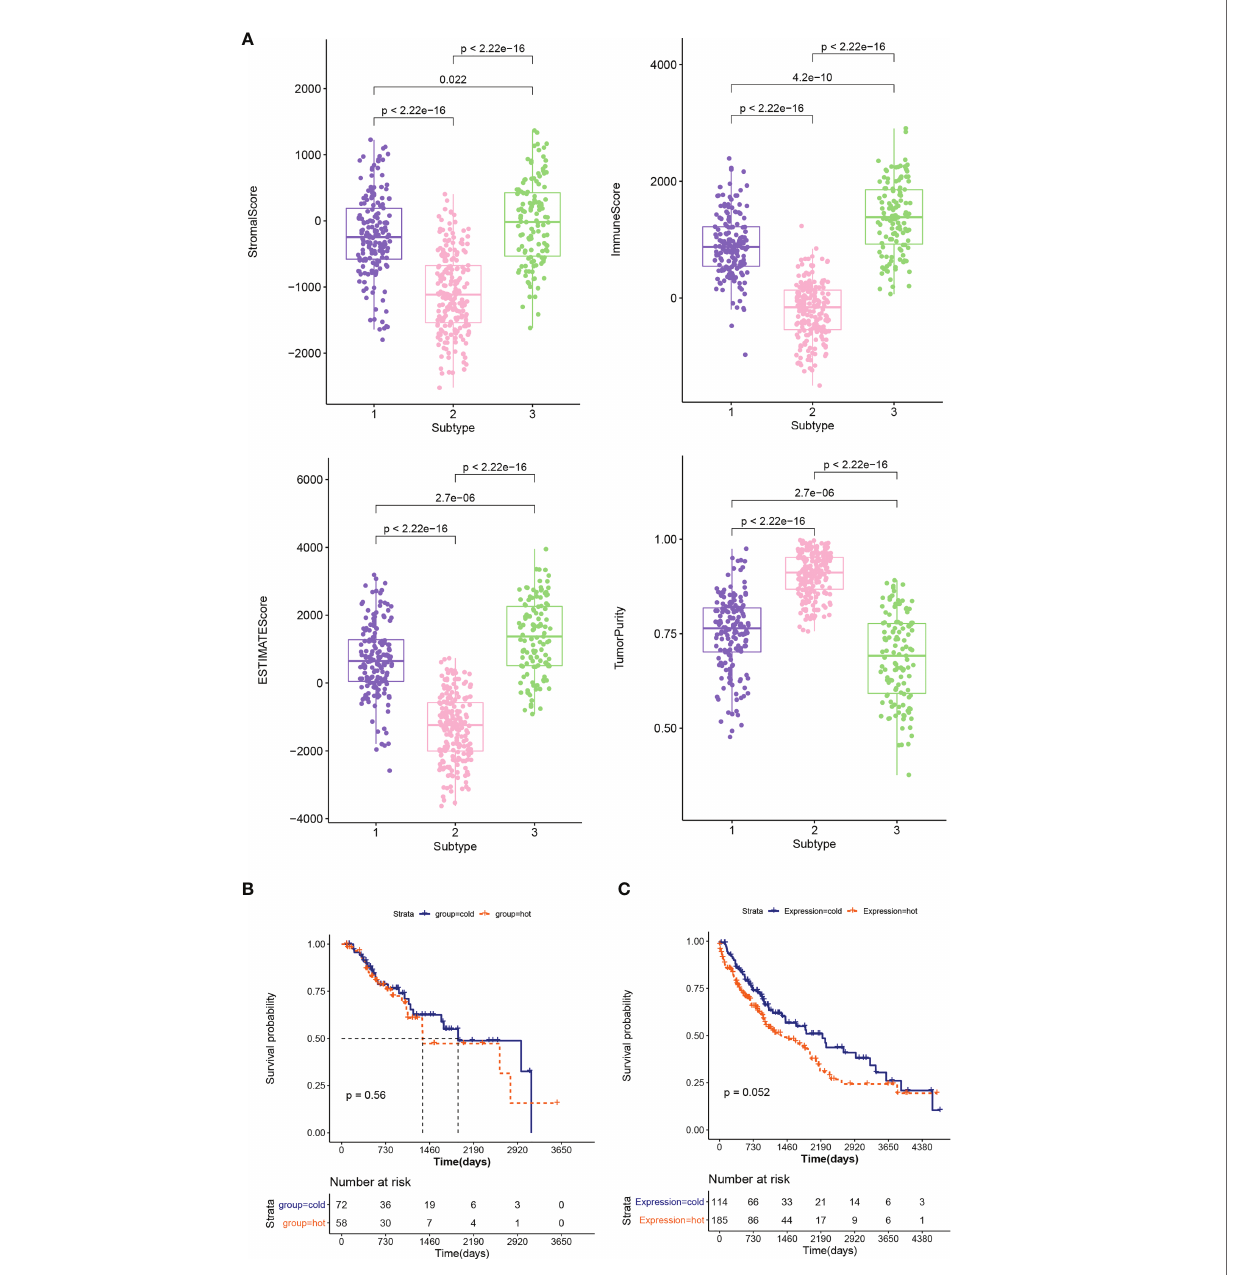
FIGURE 3 | (A) Comparison of the distribution of stroma score, ESTIMATE score, immune score, and tumor purity in different subtypes. (B, C) KM curves associated with survival outcomes between cold and hot tumor groups in chemotherapy (B) and non-treatment groups (C)